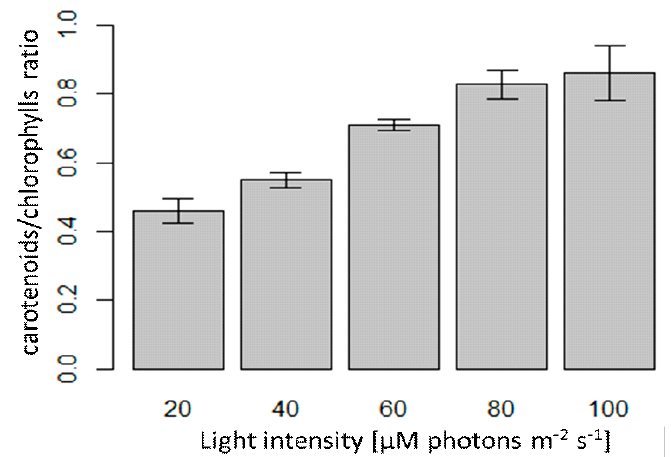
Figure 2. Final biomass and biomass growth rate (average of biomass increase per day over ten days) of Haematococcus pluvialis under different light intensities (in the range of 20–100 µmol photons m − 2 ·s − 1 ).